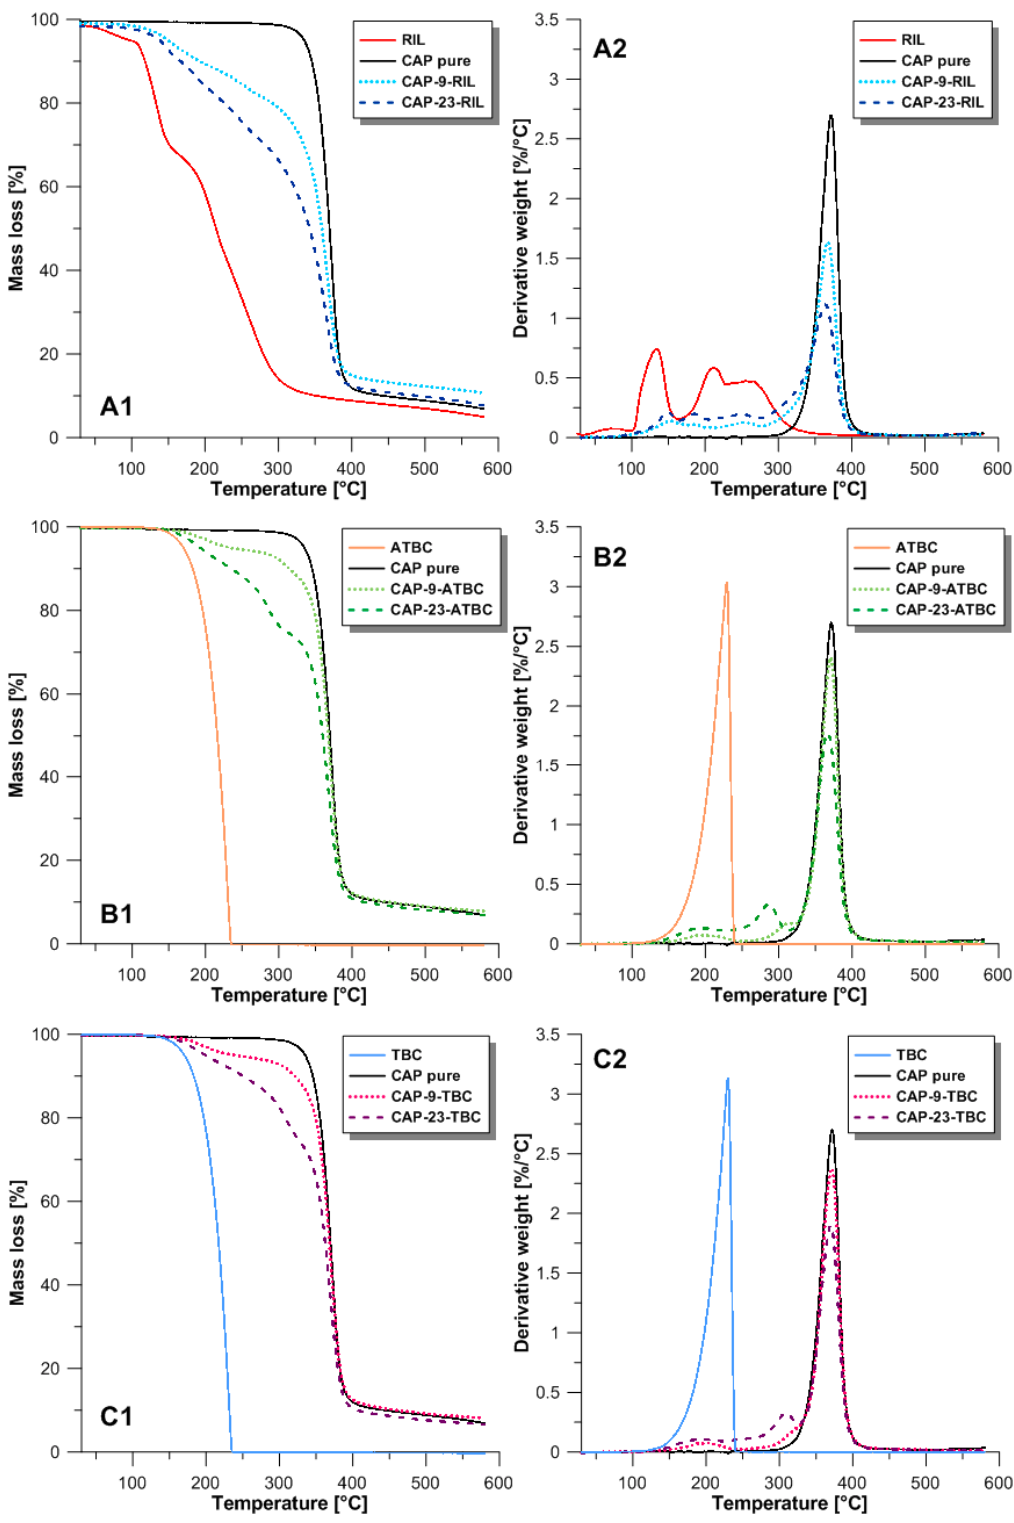
Figure 5. Thermogravimetric analysis (TGA) and derivative thermo-gravimetric analysis (DTG) of membranes doped by RIL ( A ); ATBC ( B ); and TBC ( C ).